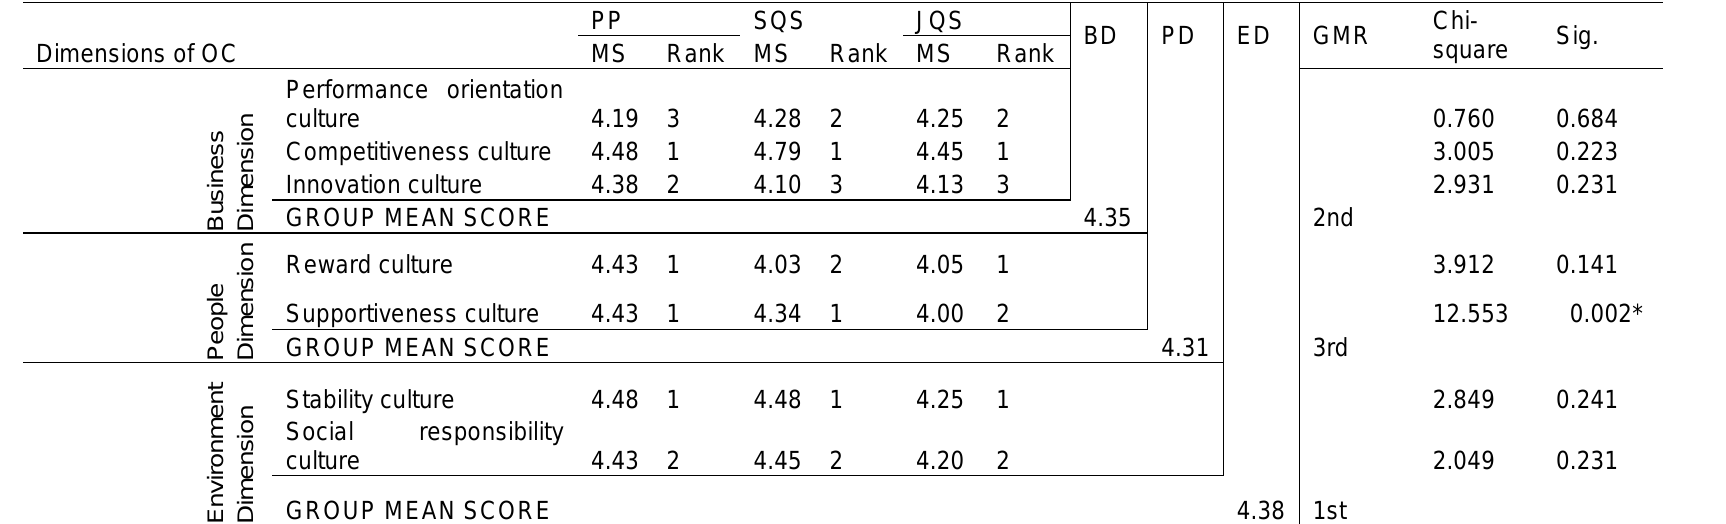
Table 1: Dimensions of organisational culture